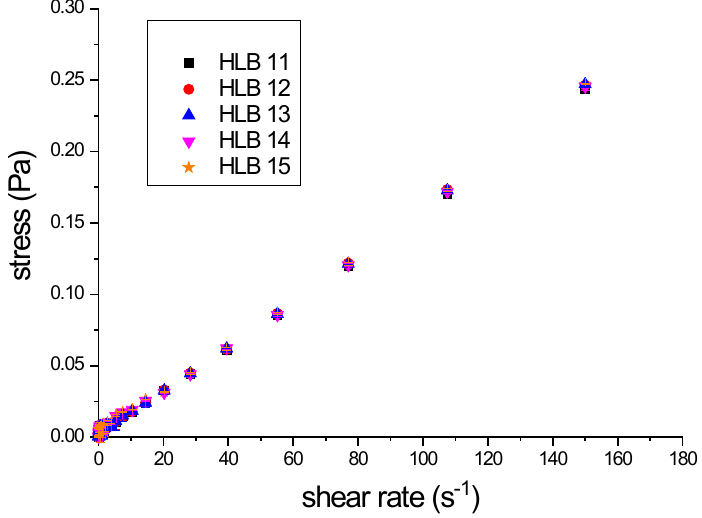
Figure 2. Flow behavior of emulsions formulated with lemon oil as a function of surfactant-mixture HLBs.